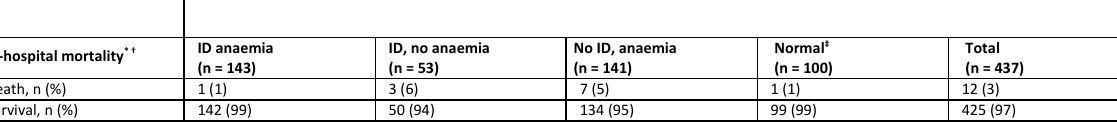
Table 2: In-hospital all-cause mortality stratified by iron status and presence of anaemia on hospital admission (number of patients = 437). Iron status / anaemia